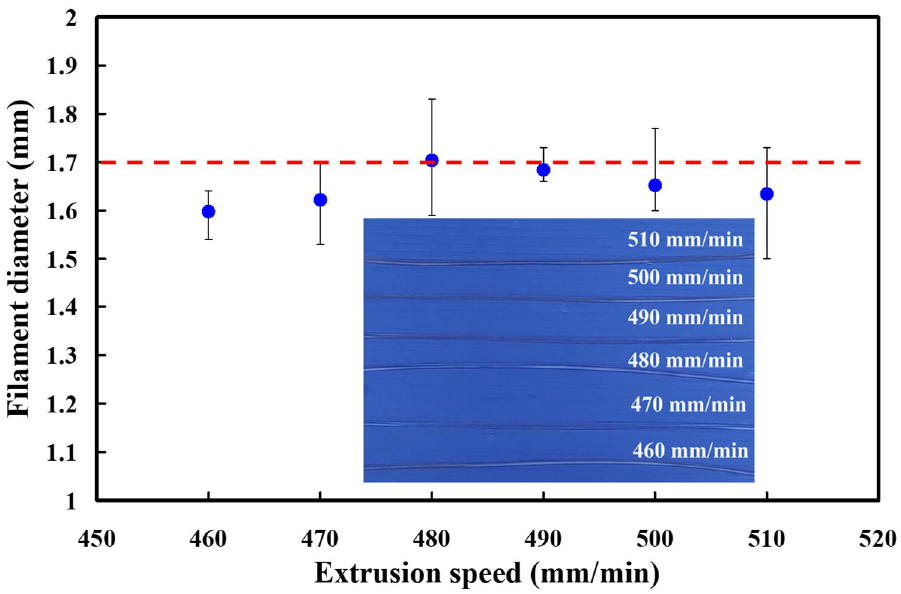
Figure 4. Effects of the extrusion speeds on the PLA filament diameter.